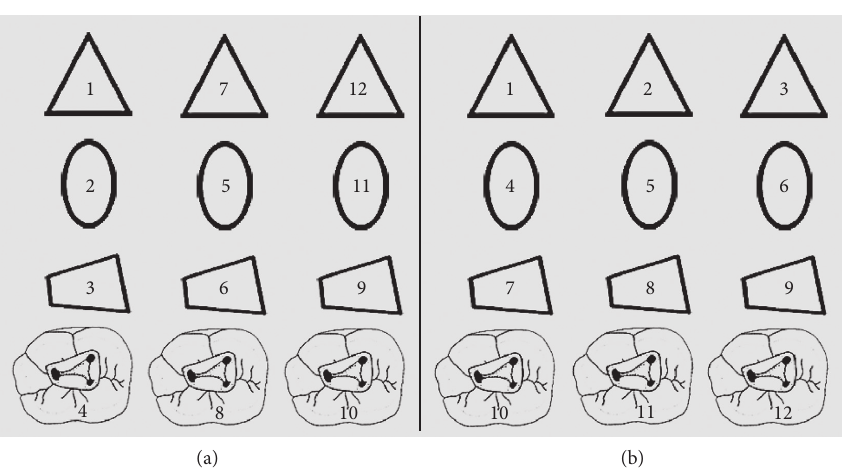
Figure 2: Simulated access cavity preparation on plastic training blocks. (a) Random practice order. (b) Blocked practice